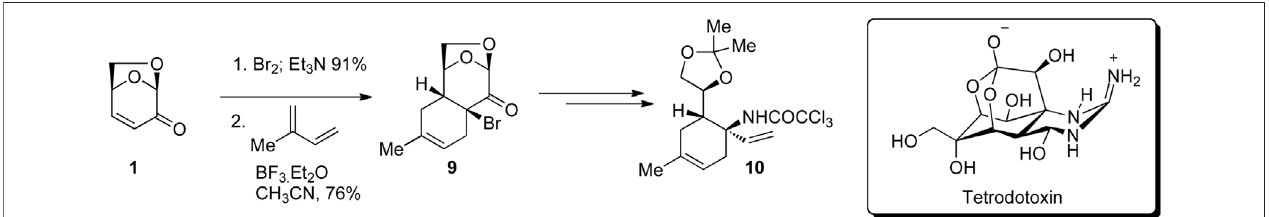
FIGURE 3 | Synthesis of tetrodotoxin key intermediate from LGO.